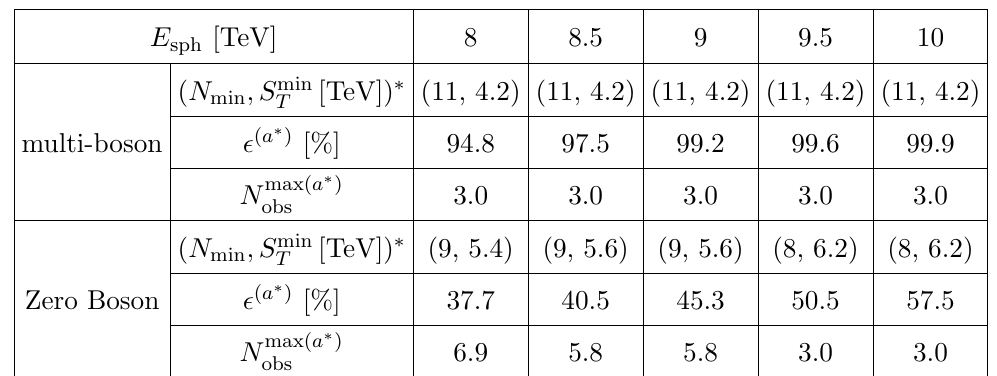
Table 1 . The most sensitive signal region ( a (cid:3) = ( N min ; S min region a (cid:3) , and the observed upper limit for signal region a (cid:3) ( N max(a of the partonic threshold energy E sph .